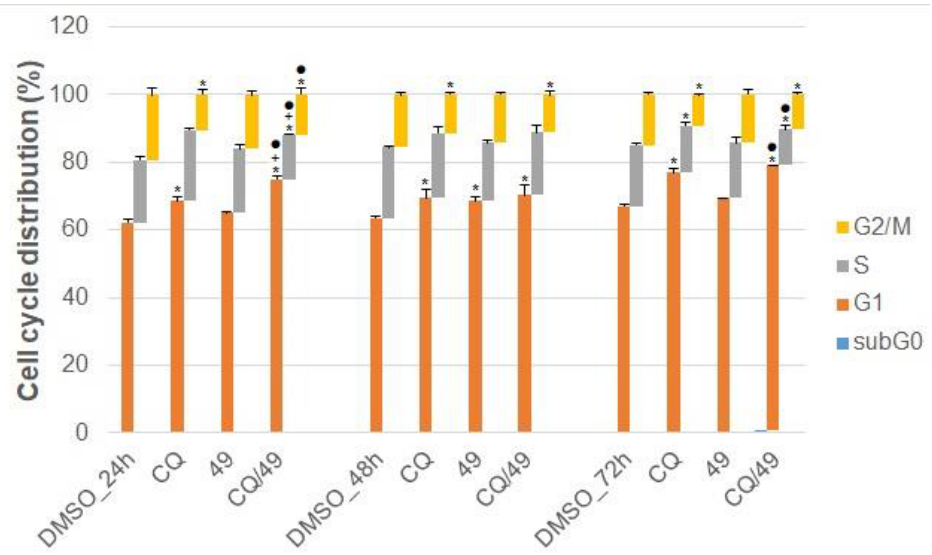
Figure 7. Effect of compound 49 alone or in combination with chloroquine (CQ) on the cell cycle progression of A549 cells after 24, 48 and 72 h incubation. The data show the mean ± SD values of three independent experiments. Statistical significance: * p < 0.05 vs. DMSO, + p < 0.05 vs. CQ, ● p < 0.05 vs. 49.